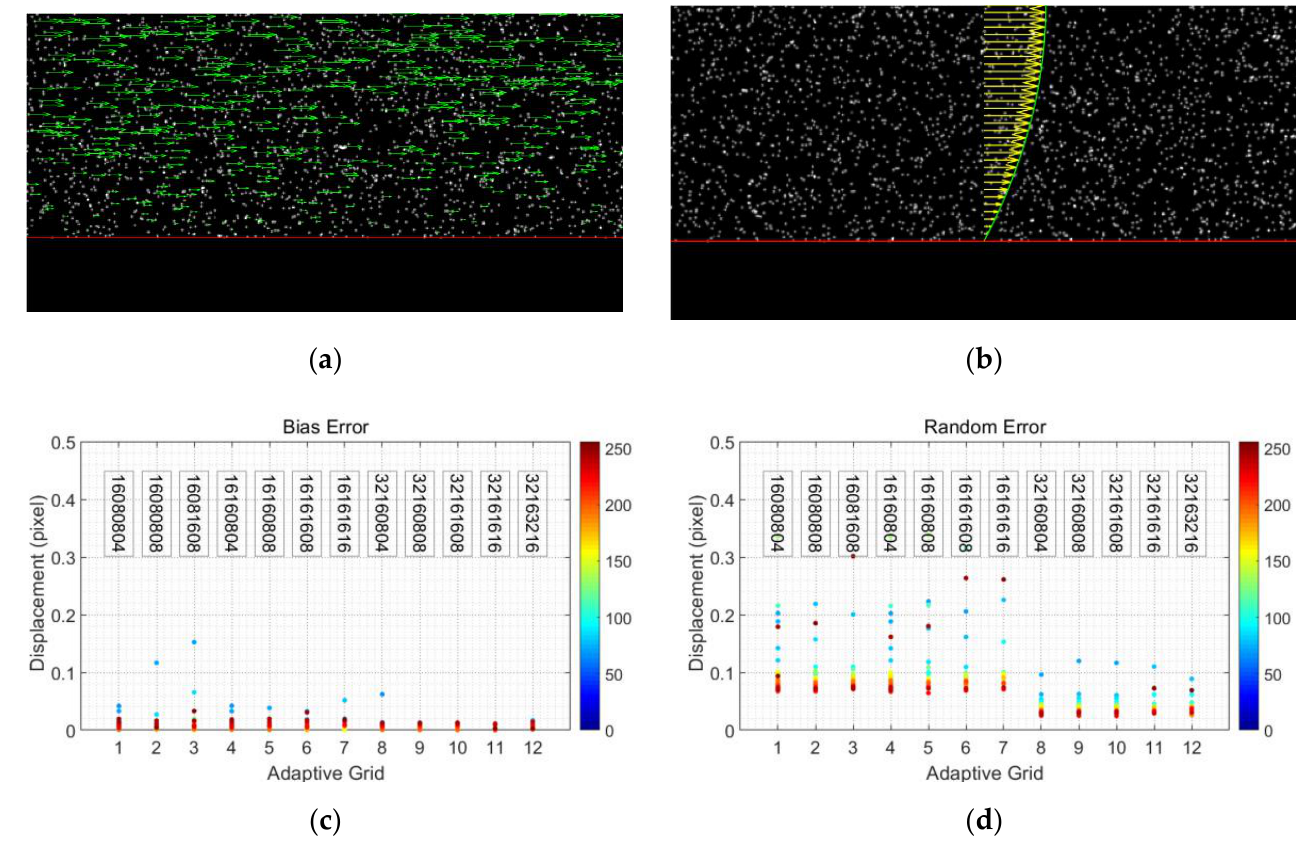
Figure 7. Adaptive PIV test with synthetic particle images: ( a , b ) synthetic particle images; ( c , d ) test results of bias error and random error, and the color scheme associated with the data points corresponds to the vertical pixel position. Texts in ( c , d ) suggested the applied adaptive PIV parameters: the initial 4-digit number were the minimum IA size, and the last 4 represented the grid step size.